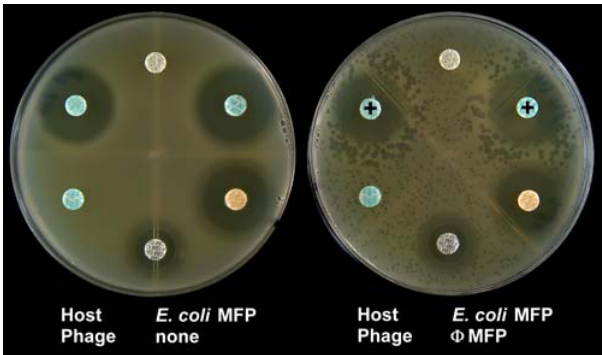
Figure 1. The PAS effect of phage w MFP on E.coli MFP on Luria- Bertani agar plates. Only disks containing the b -lactam antibiotics aztreonam and cefixime (indicated by ‘‘ + ’’ symbols) produced large phage plaques in their proximity. Gentamicin and tetracycline gave no PAS effect. This host strain was resistant to both amoxicillin and trimethoprim/sulfamethoxazole. Note the absence of phages on the left-hand control plate indicating the lack of prophage induction. doi:10.1371/journal.pone.0000799.g001 optimal concentration, 50 ng/mL. Concentrations of cefotaxime